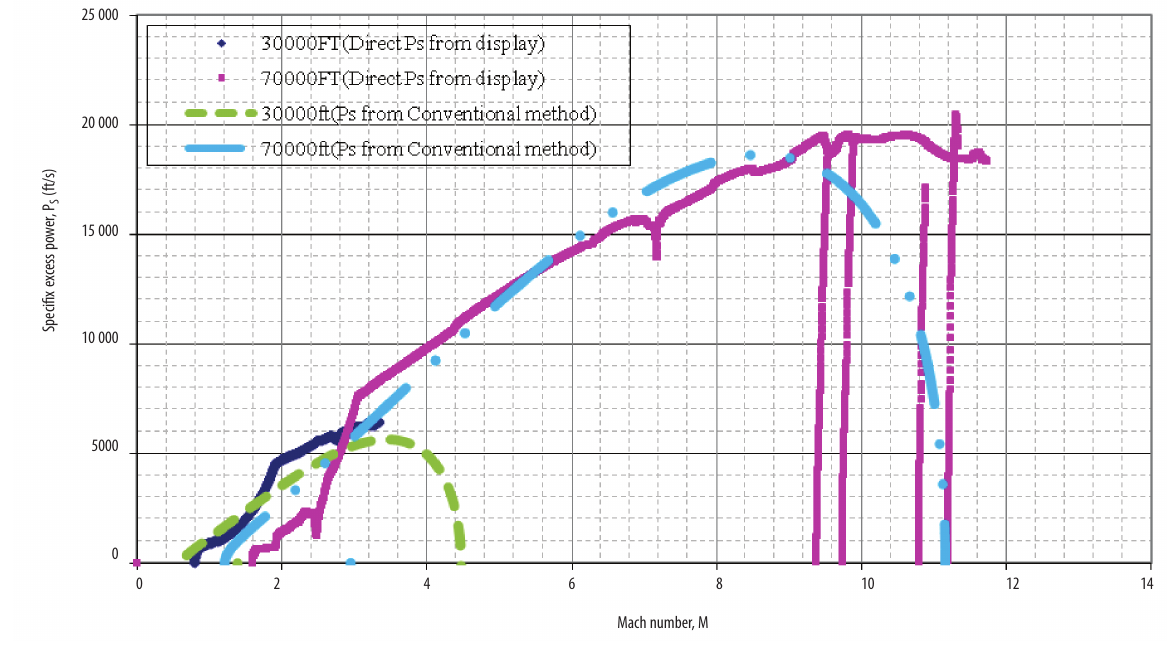
Fig. 5. Specific excess power, P S (ft/s) versus Mach number, M for X-30 aircraft (conventional method and direct P S from display). (Engine: rocket, config.; clean config. Maximum power setting, W: 550,000 lbs. Method: level acceleration, flight conditions: Hpo ~10,000 ft -80,000 ft, Mach~0.7–16